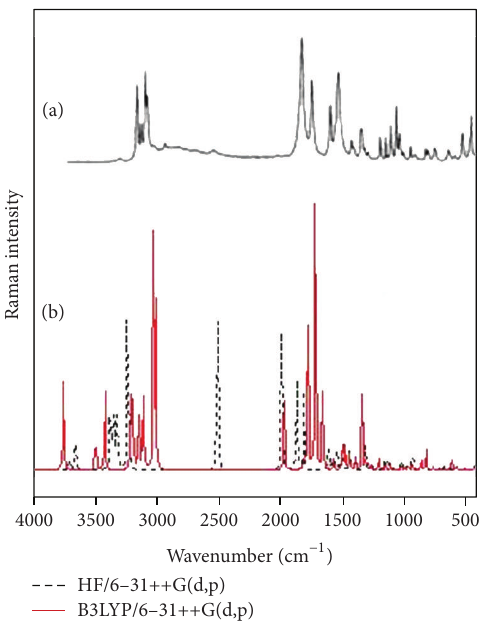
F 2: (a) e experimental FT-IR spectrum [18]. (b) e calculated IR spectra of sarcosine-maleic acid. calculated Raman spectra of sarcosine-maleic